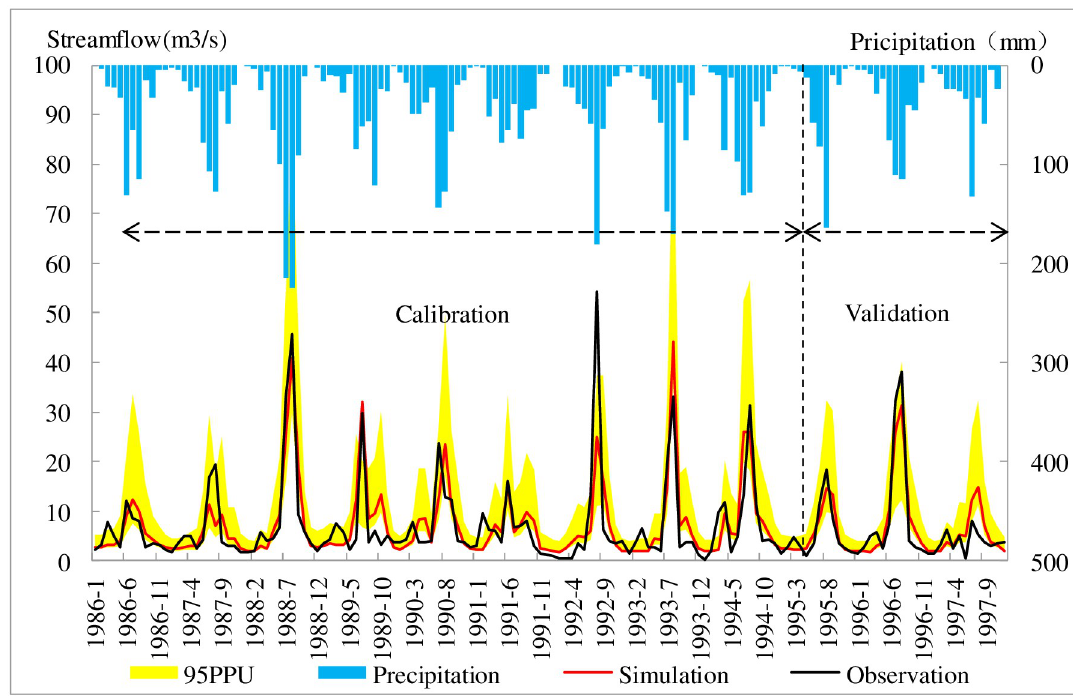
Fig 4. Time series plot between the observed and simulated streamflows at the monthly time scale and 95% prediction uncertainty bands.